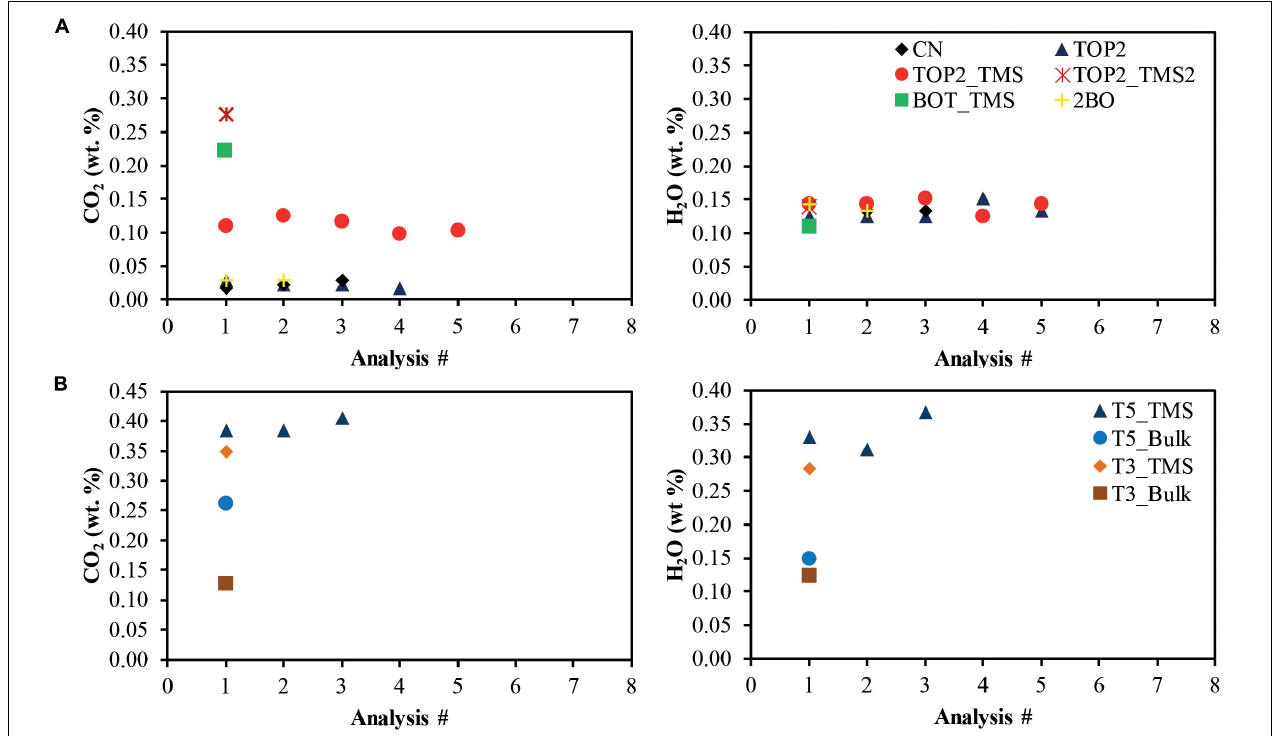
FIGURE 9 | CHNS-O values for CO 2 and H 2 O for (A) samples in contact with tree, and (B) the J74 samples. Samples in contact with tree are enriched in meteoric volatiles (CO 2 ). The handpicking method increases this discrepancy, as shown by the concentration in CO 2 for BOT-TMS and TOP2-TMS2